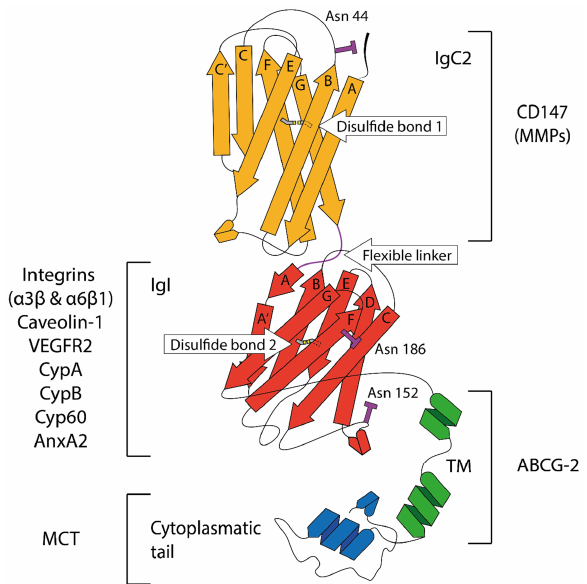
Figure 1. Structure of CD147/bsg ‐ 2 with the two Ig domains (IgC2 and IgI) connected by a flexible linker, the transmembrane domain and the cytoplasmatic domain. The cartoon shows the diagram ‐ matic representation of the molecular structure of CD147 and molecules potentially interacting with each domain based on previous reports [249,250,255]. Letters label molecular strands forming Ig domains. The N ‐ terminal domain (IgC2, orange) has a disulfide bond connecting strand B and F (between C41 and C87, respectively) and an N ‐ linked glycosylation site at Asn ‐ 44 at the end of strand B. This domain is responsible for homophilic interactions and influences MMP activity. The C ‐ terminal domain (IgI, red) has a disulfide bond connecting B and F strand (between C126 and C185, respectively) and two potential glycosylation sites at Asn ‐ 152 and Asn ‐ 186. The flexible linker is shown in purple, the transmembrane domain (TM) in green and the cytoplasmatic domain in blue.